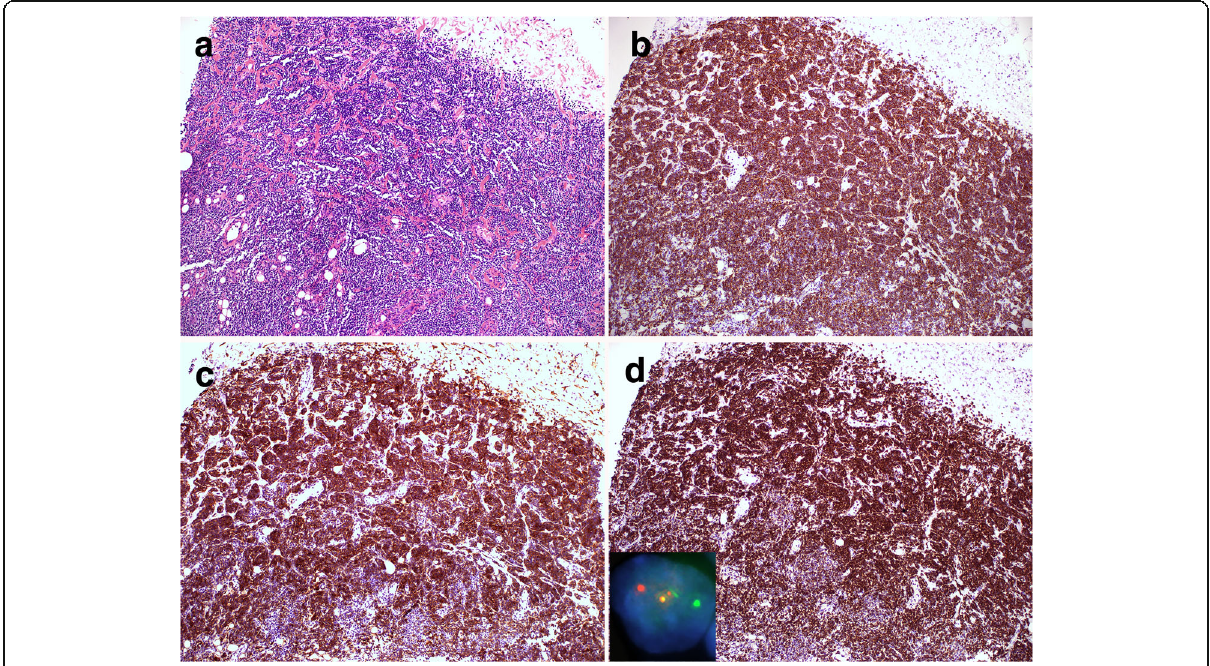
Fig. 3 Recurrent low grade follicular lymphoma . A needle core biopsy reveals an abnormal infiltrate of small lymphocytes that are predominantly CD20+ B cells with coexpression of CD10, BCL6 and BCL2, consistent with low grade follicular lymphoma ( a H&E, 200X, b CD20 IHC, 200X; c CD10, 200X, d BCL2 IHC, 200X). Dual color dual fusion FISH analysis confirms the presence of IgH/BCL2 fusion signals resulting from t(14;18) in 62% of cells analyzed